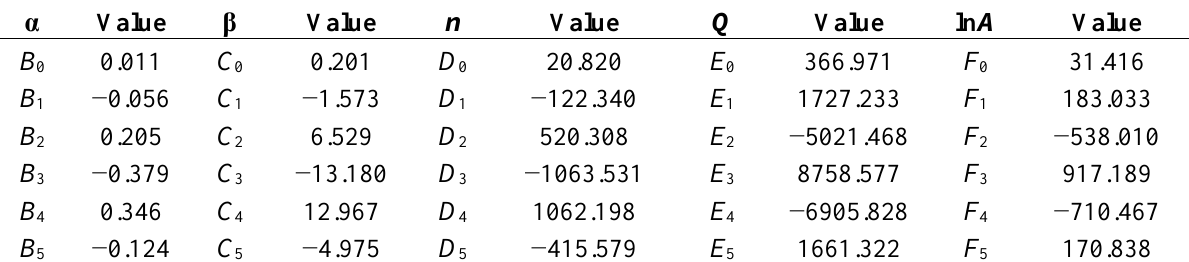
Table 2. The polynomial fitting results of constants and coefficients of α , β , n , Q , and ln A